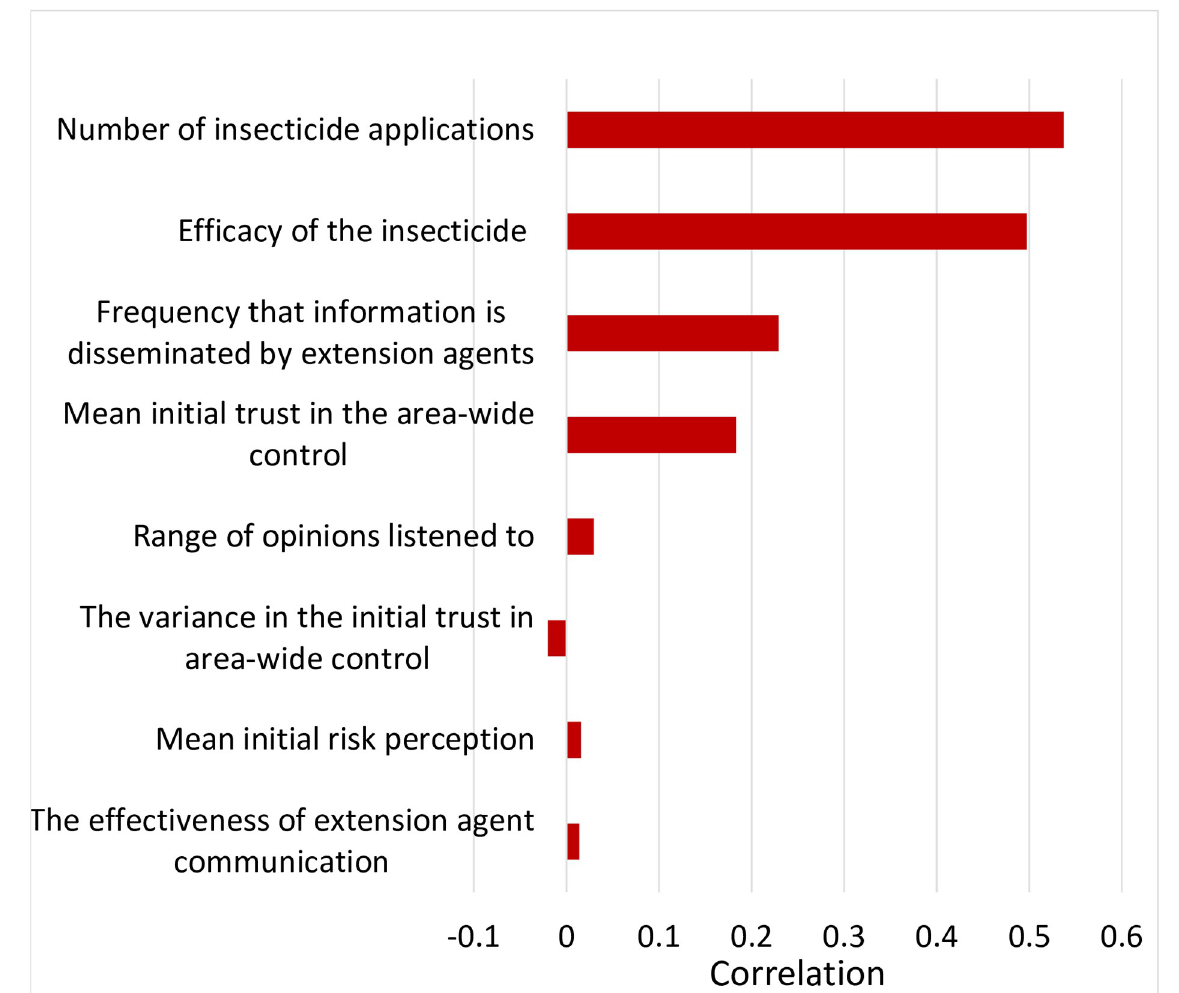
Fig 4. Tornado graph showing the correlation between each variable and the proportion of cells